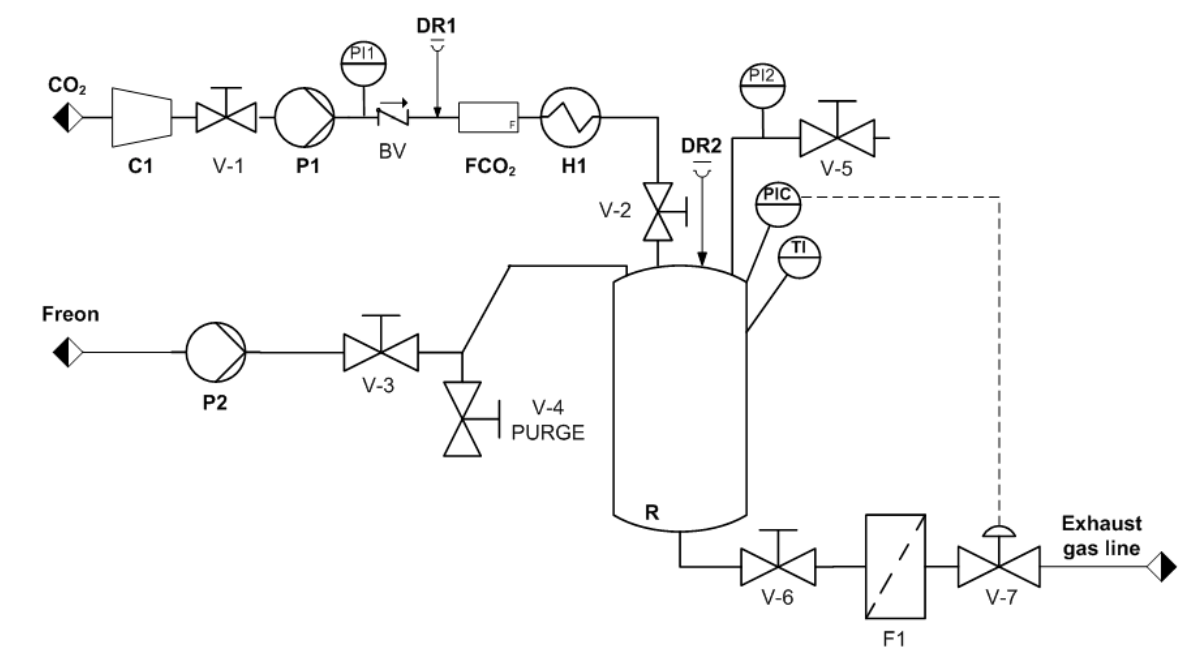
Figure 1. Diagram of the equipment used for preparing 3D porous polymeric scaffolds with compressed CO 2 or Freon R134a. P1 and P2: pumps for compressing the fluids; DR1 and DR2: rupture disks; F1: mass flow meter; V-1/V-7: valves; H1: heater; R: high-pressure vessel; F1 and FCO 2 : filters; PI1 and PI2: pressure indicators; PIC: pressure controller; TI: temperature indicator.